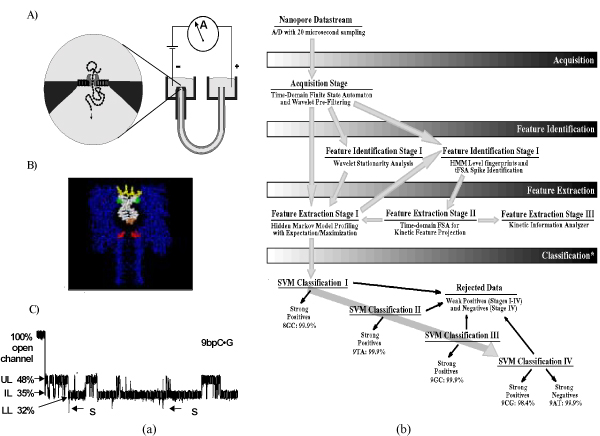
a. (A) shows a nanopore device based on the α-hemolysin channel (from [8]). It has been used for analysis of single DNA molecules, such as ssDNA, shown, and dsDNA, a nine base-pair DNA hairpin is shown in (B) superimposed on the channel geometry. The channel current blockade trace for the nine base-pair DNA hairpin blockade from (B) is shown in (C). b. The signal processing architecture that was used to classify DNA hairpins with this approach: Signal acquisition was performed using a time-domain, thresholding, Finite State Automaton, followed by adaptive pre-filtering using a wavelet-domain Finite State Automaton. Hidden Markov Model processing with Expectation-Maximization was used for feature extraction on acquired channel blockades. Classification was then done by Support Vector Machine on five DNA molecules: four DNA hairpin molecules with nine base-pair stem lengths that only differed in their blunt-ended DNA termini, and an eight base-pair DNA hairpin. The accuracy shown is obtained upon completing the 15th single molecule sampling/classification (in approx. 6 seconds), where SVM-based rejection on noisy signals was employed.